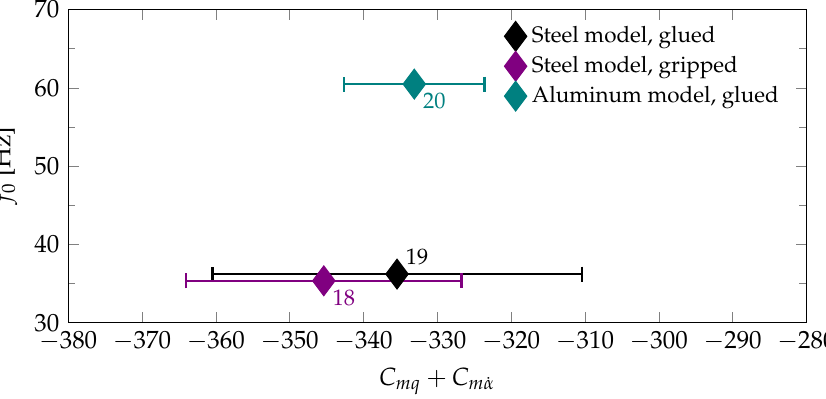
Figure 13. Oscillation frequency over C mq + C m ˙ α for the Basic Finner at Mach 1.28 (numbers according to Table